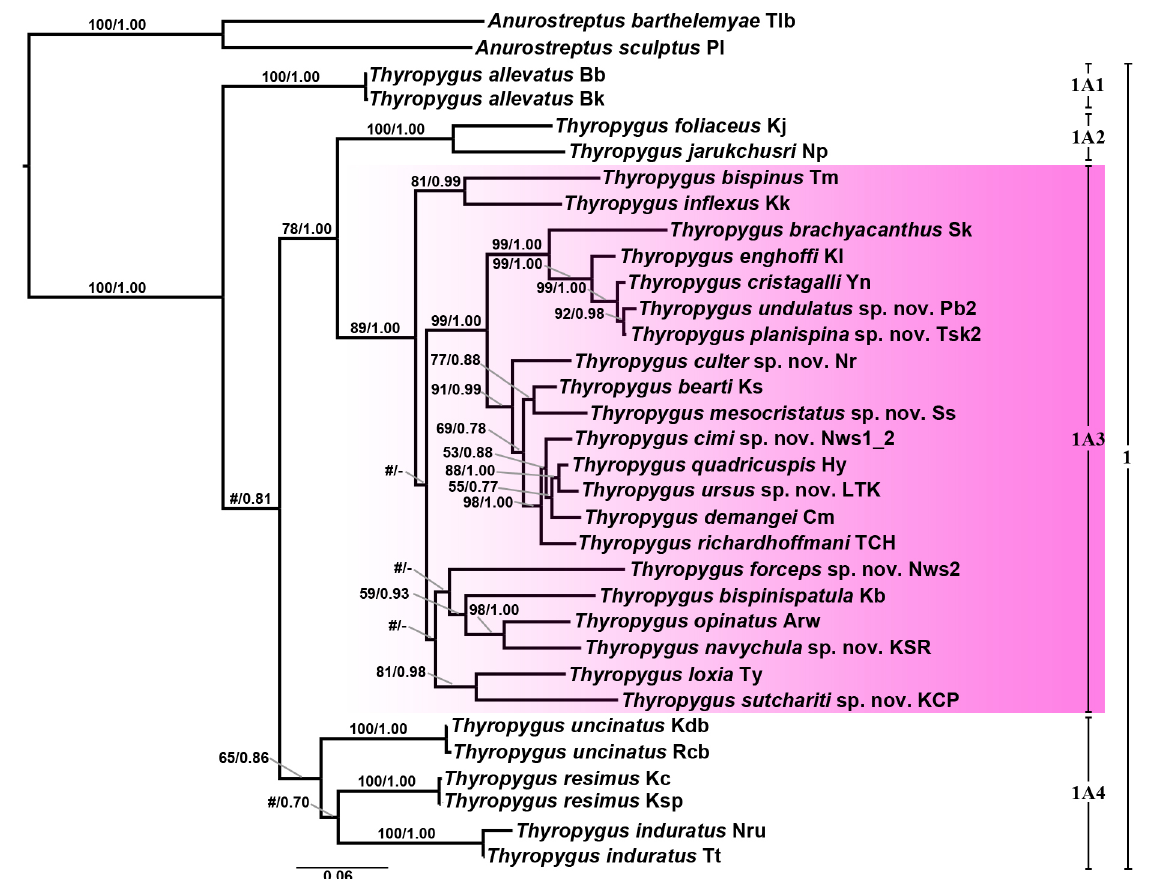
Fig. 1. Phylogenetic relationships of Thyropygus species based on maximum likelihood analysis (ML) and Bayesian Inference (BI) of 1147 bp of concatenated gene fragments of COI (660 bp) and 16S rRNA (487 bp). Numbers at nodes indicate branch support based on bootstrapping (ML) / posterior probability (BI). Scale bar = 0.06 substitutions/site. # indicates branches which received < 50% ML bootstrap support, - indicates non-supported branches by posterior probability. Clade memberships and designations are shown as vertical bars; 1A1 = T. allevatus , 1A2 = cuisinieri subgroup, 1A3 = opinatus subgroup and 1A4 = induratus subgroup. The coloured area marks the T. opinatus subgroup. Abbreviations after species names refer to locality names as shown in Table